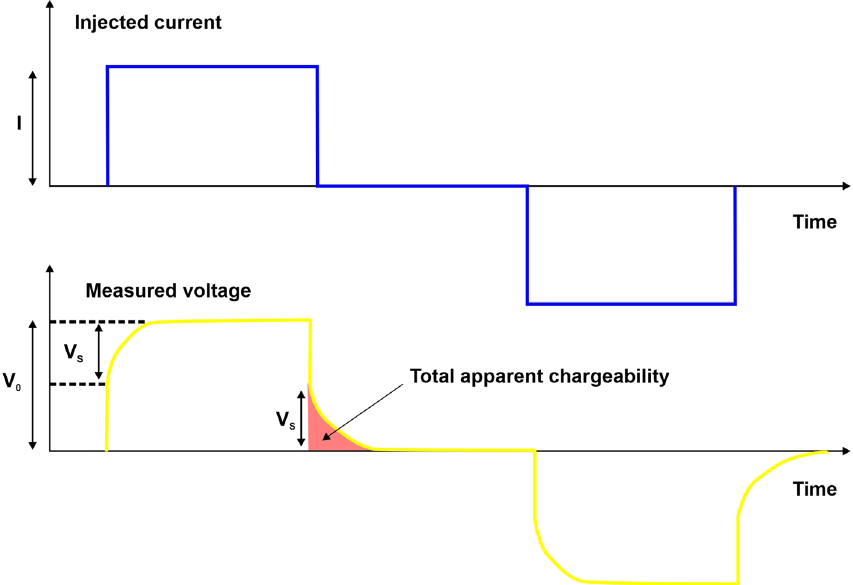
Figure 10. Representation of electrical measurements. The figure was created using the Corel Draw 17 commercial software (https:// www. corel draw. com/ it/ produ ct/ corel